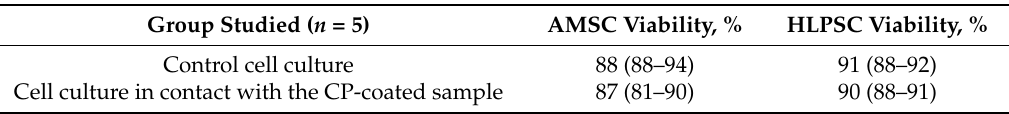
Table 1. Percentage of viable AMSCs or prenatal stromal cells from the human lung (HLPSCs) after cultivation with a CP-coated surface for 21 or 4 days, Me (Q 1 – Q 3 ).